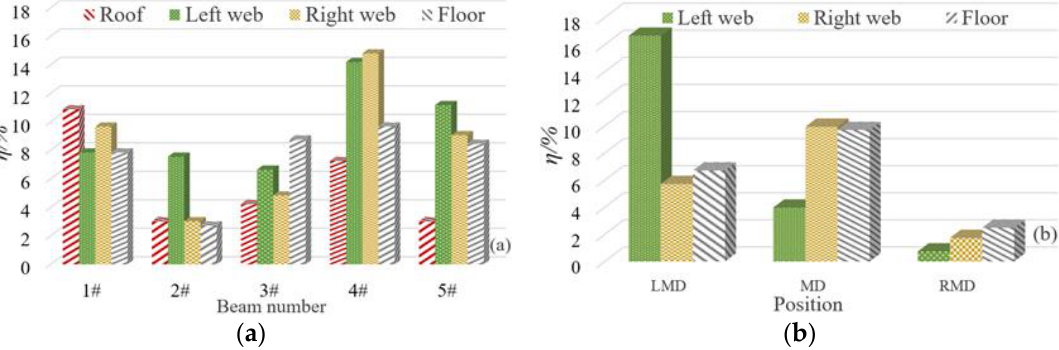
Figure 2. ƞ of chloride concentration at each measuring point of the test box girder; ( a ) ƞ of RH less than 70; ( b ) ƞ of RH higher than 70.